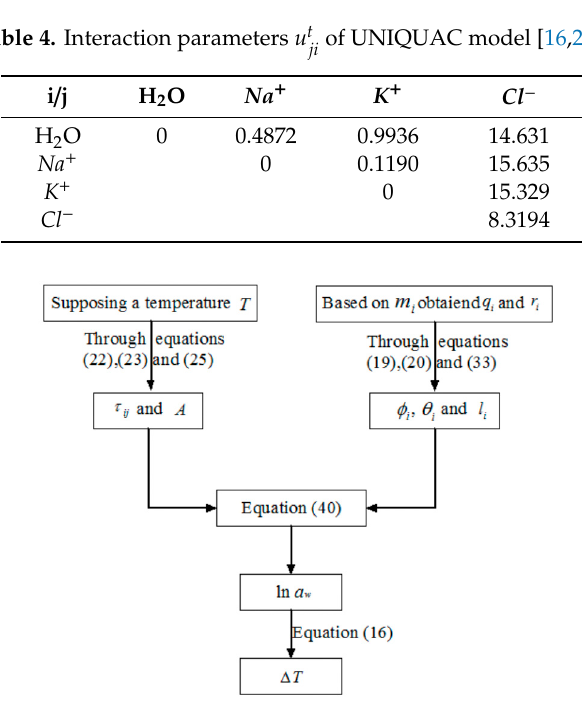
Figure 8. Schematic diagram of freezing point calculation process.